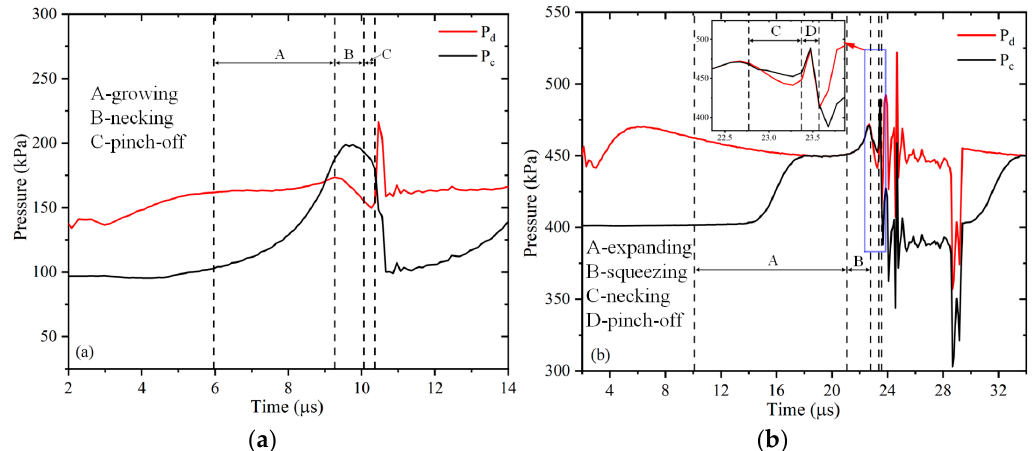
Figure 12. Pressure curve: ( a ) improved microchannel; ( b ) traditional microchannel (Ca = 0.0139, U d = 0.2 m/s).